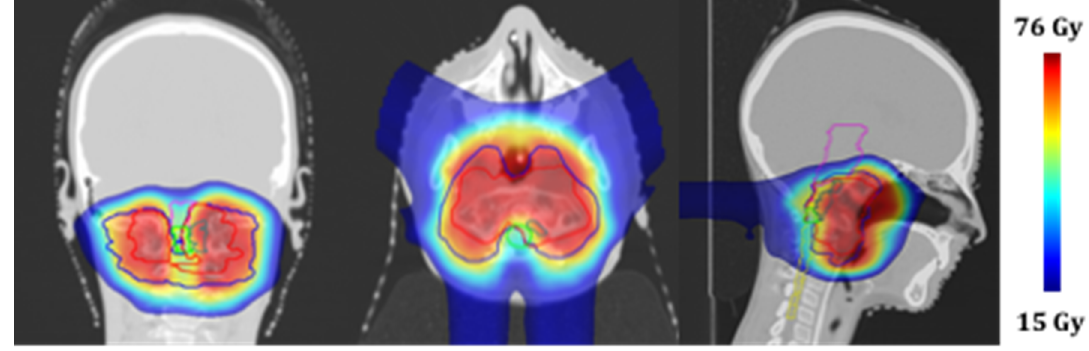
Figure 3. Treatment planning: proton dose distributions in coronal, axial and sagittal views. The following contours are reported: planning target volume 0–54 GyRBE (blue), planning target volume 54–73.4 GyRBE (red), nodule component (green), brainstem (purple), and spinal cord (yellow).